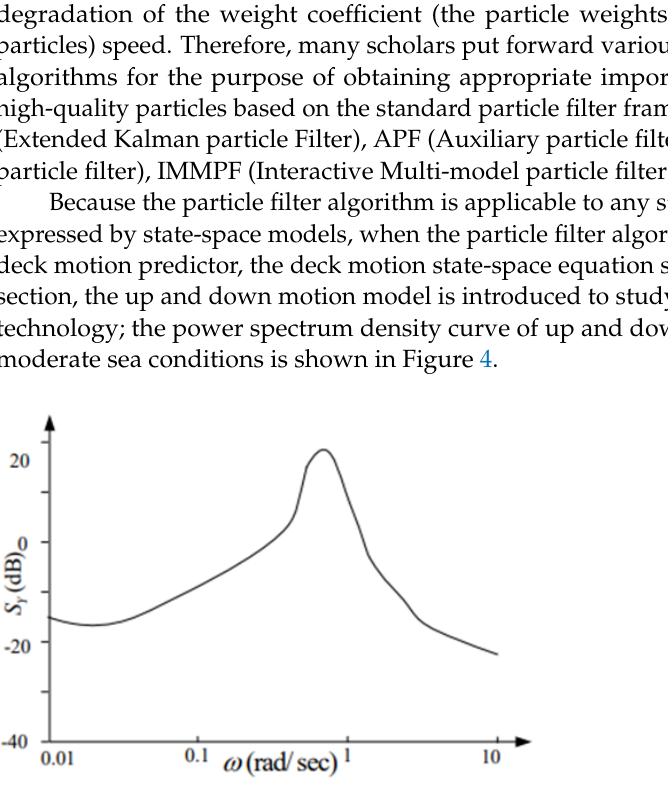
Figure 4. The power spectrum density curve of up and down motion.